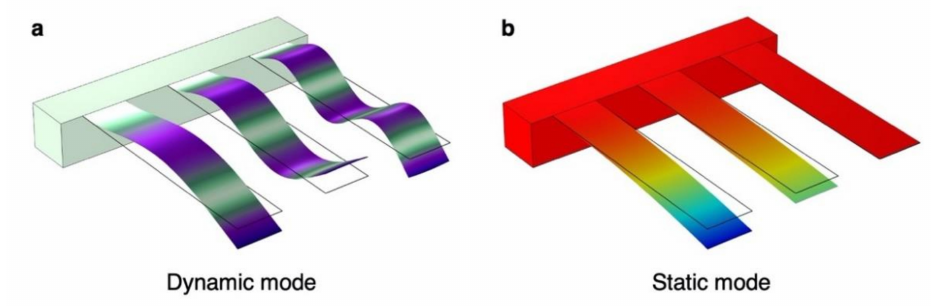
Figure 3. Schematic illustrations of two different operation modes of cantilever-type nanomechanical sensors simulated by finite element analysis (FEA) through COMSOL Multiphysics. ( a ) Dynamic mode operation, in which a nanomechanical sensor detects sorption-induced changes in the resonance frequencies with mass effect, stiffness effect, and effect of surface stress. ( b ) Static mode operation, in which a nanomechanical sensor detects changes in the deflection caused by the sorption-induced surface stress. It is important to note that the bending of a cantilever plate is not caused by the gravity